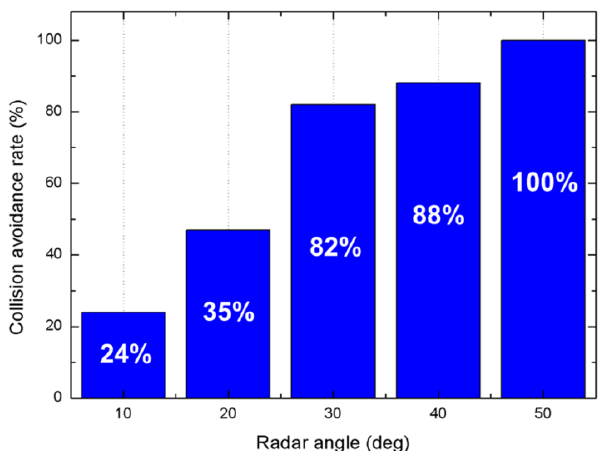
Figure 18. Collision avoidance rates from additional simulations.